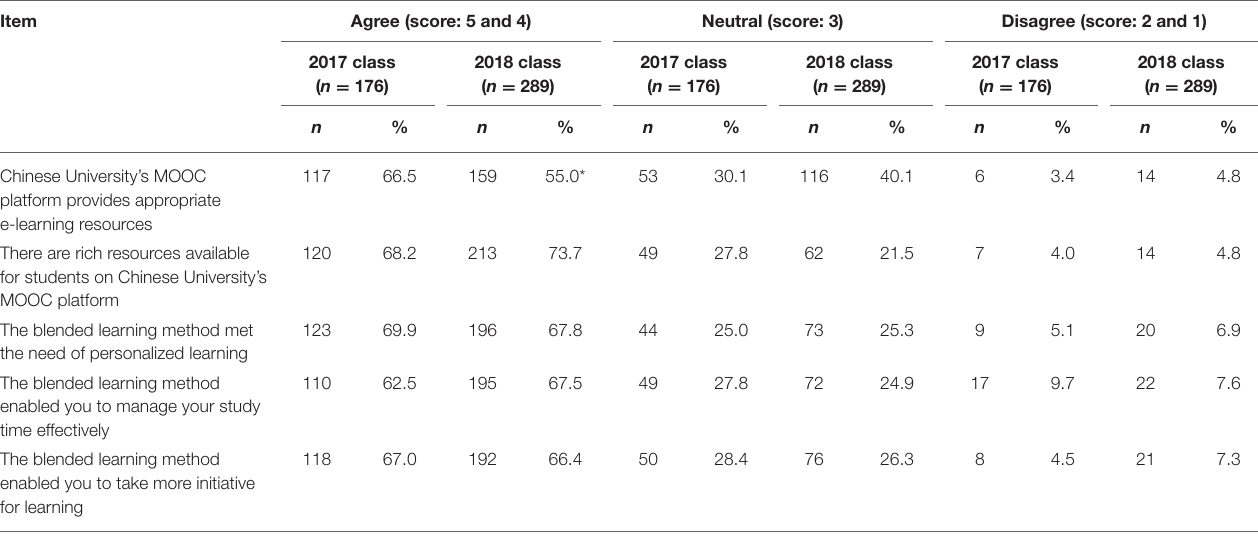
TABLE 2 | Responses from medical students regarding the blended learning experience.